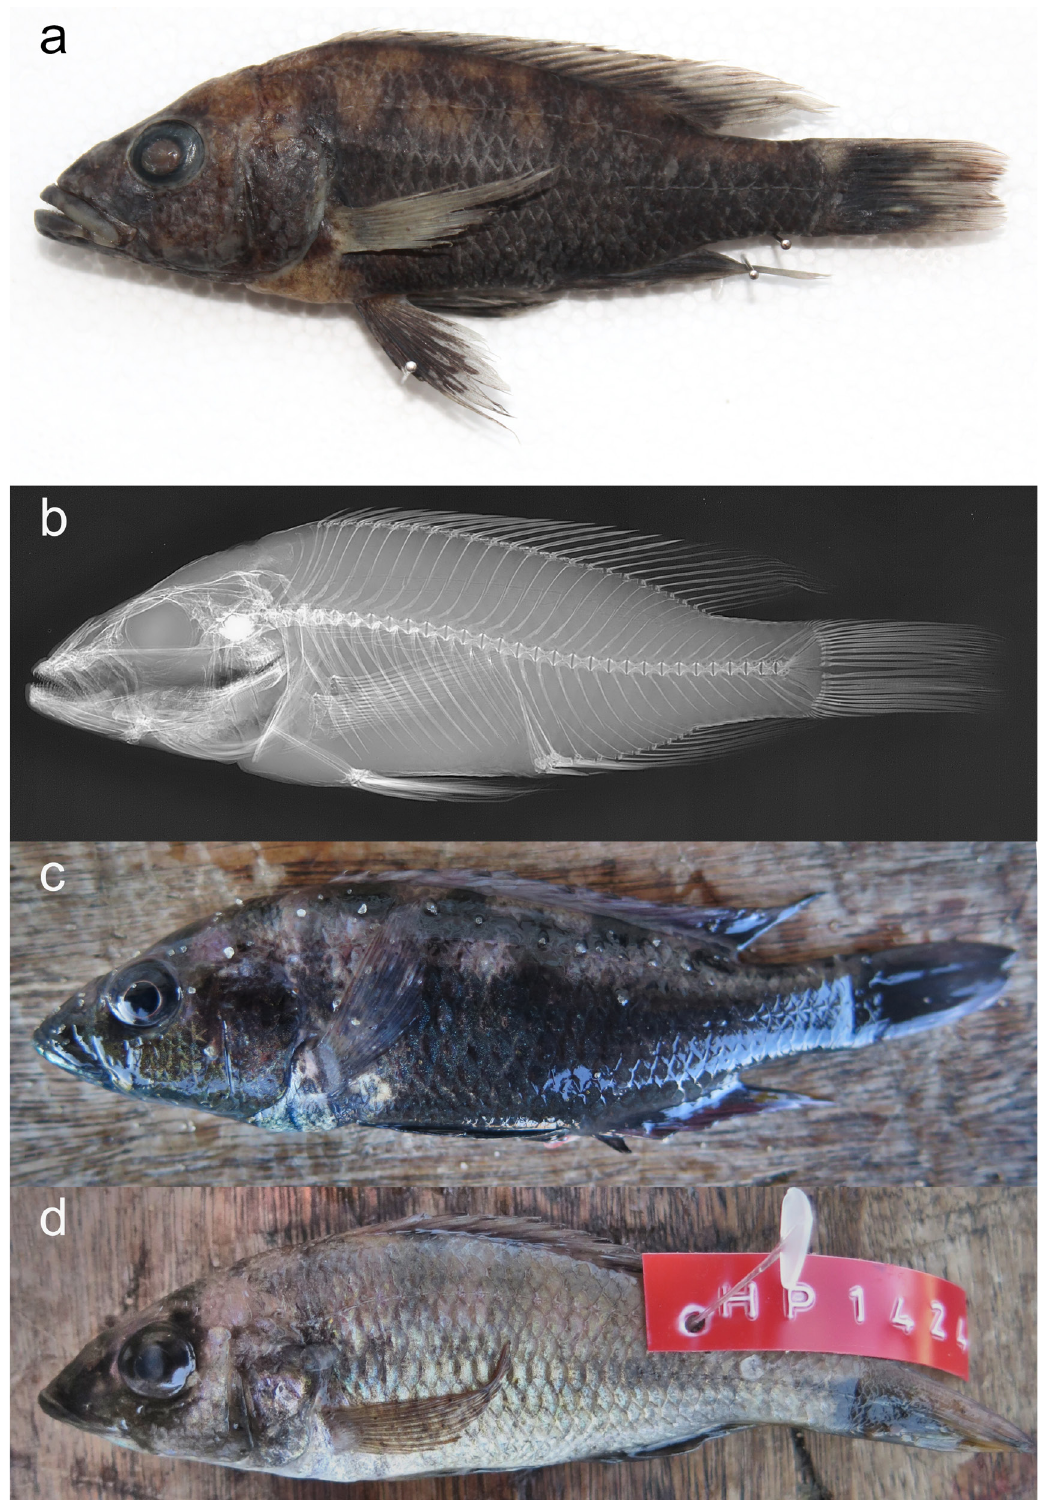
Fig. 33. Haplochromis pardus sp. nov. a . Photograph of preserved holotype (RMCA 2016.035.P.0202; 89.2 mm SL). b . X-ray image of holotype. c – d . Photographs of freshly caught specimens. c . Dominant male (RMCA 2017.006.P (HP1463); 81.4 mm SL). d . Female (RMCA 2017.006.P.0342; 75.9 mm SL) to illustrate the live colour patterns. The contrast was slightly